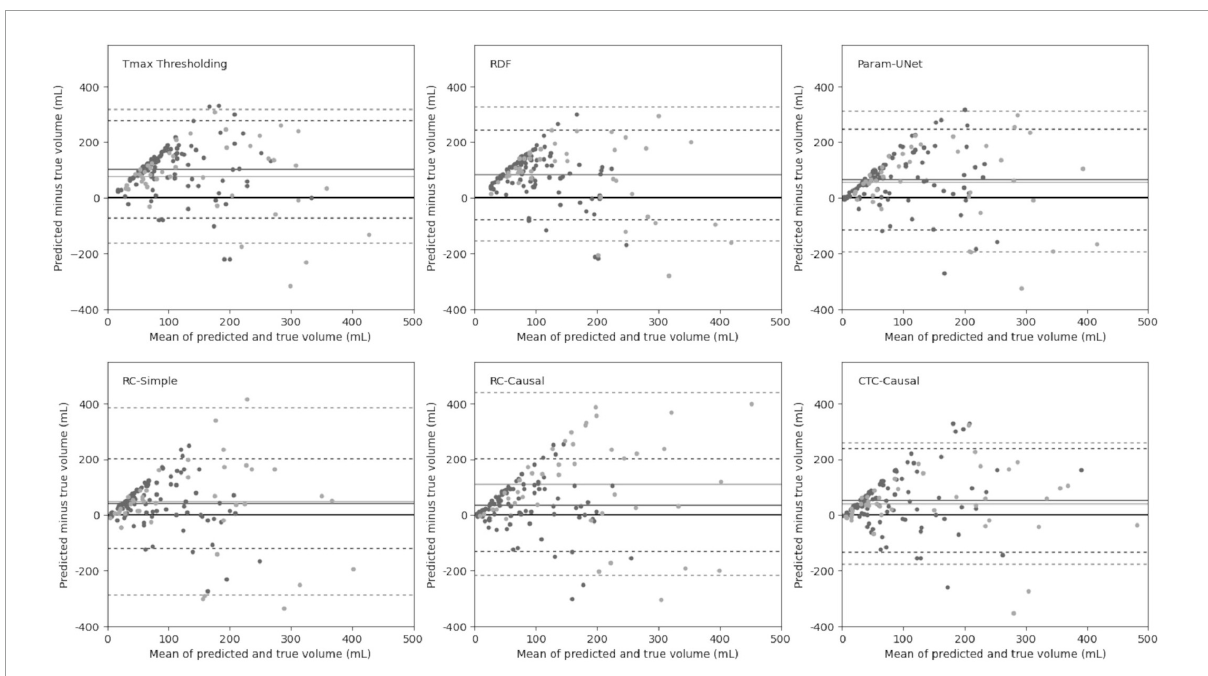
FIGURE4 Bland–Altman plots for the predicted infarct volumes of each tissue outcome prediction method. Dark markers and lines represent patients treated with intravenous tPA (IV) alone, while light markers and lines represent patients treated with intra-arterial mechanical thrombectomy (IA) with or without combined IV. Abbreviated model names correspond to: Tmax thresholding, random decision forests (RDF), deep learning from perfusion parameter maps (Param-UNet), deep learning from deconvolved residual curves with convolutional (RC-Simple) or causal convolutional (RC-Causal) feature extraction, and deep learning from source concentration-time curves